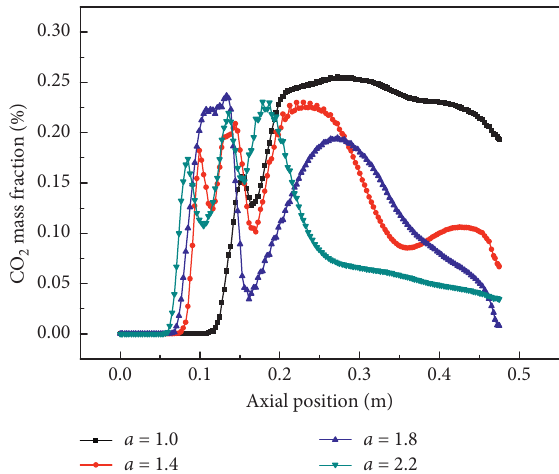
Figure 11: CO 2 concentration distribution along the longitudinal centerline of the burner under different excess air